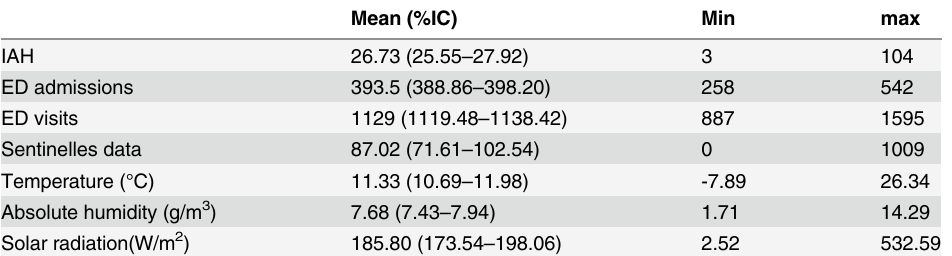
Table 2. Descriptive statistics of epidemic and meteorological